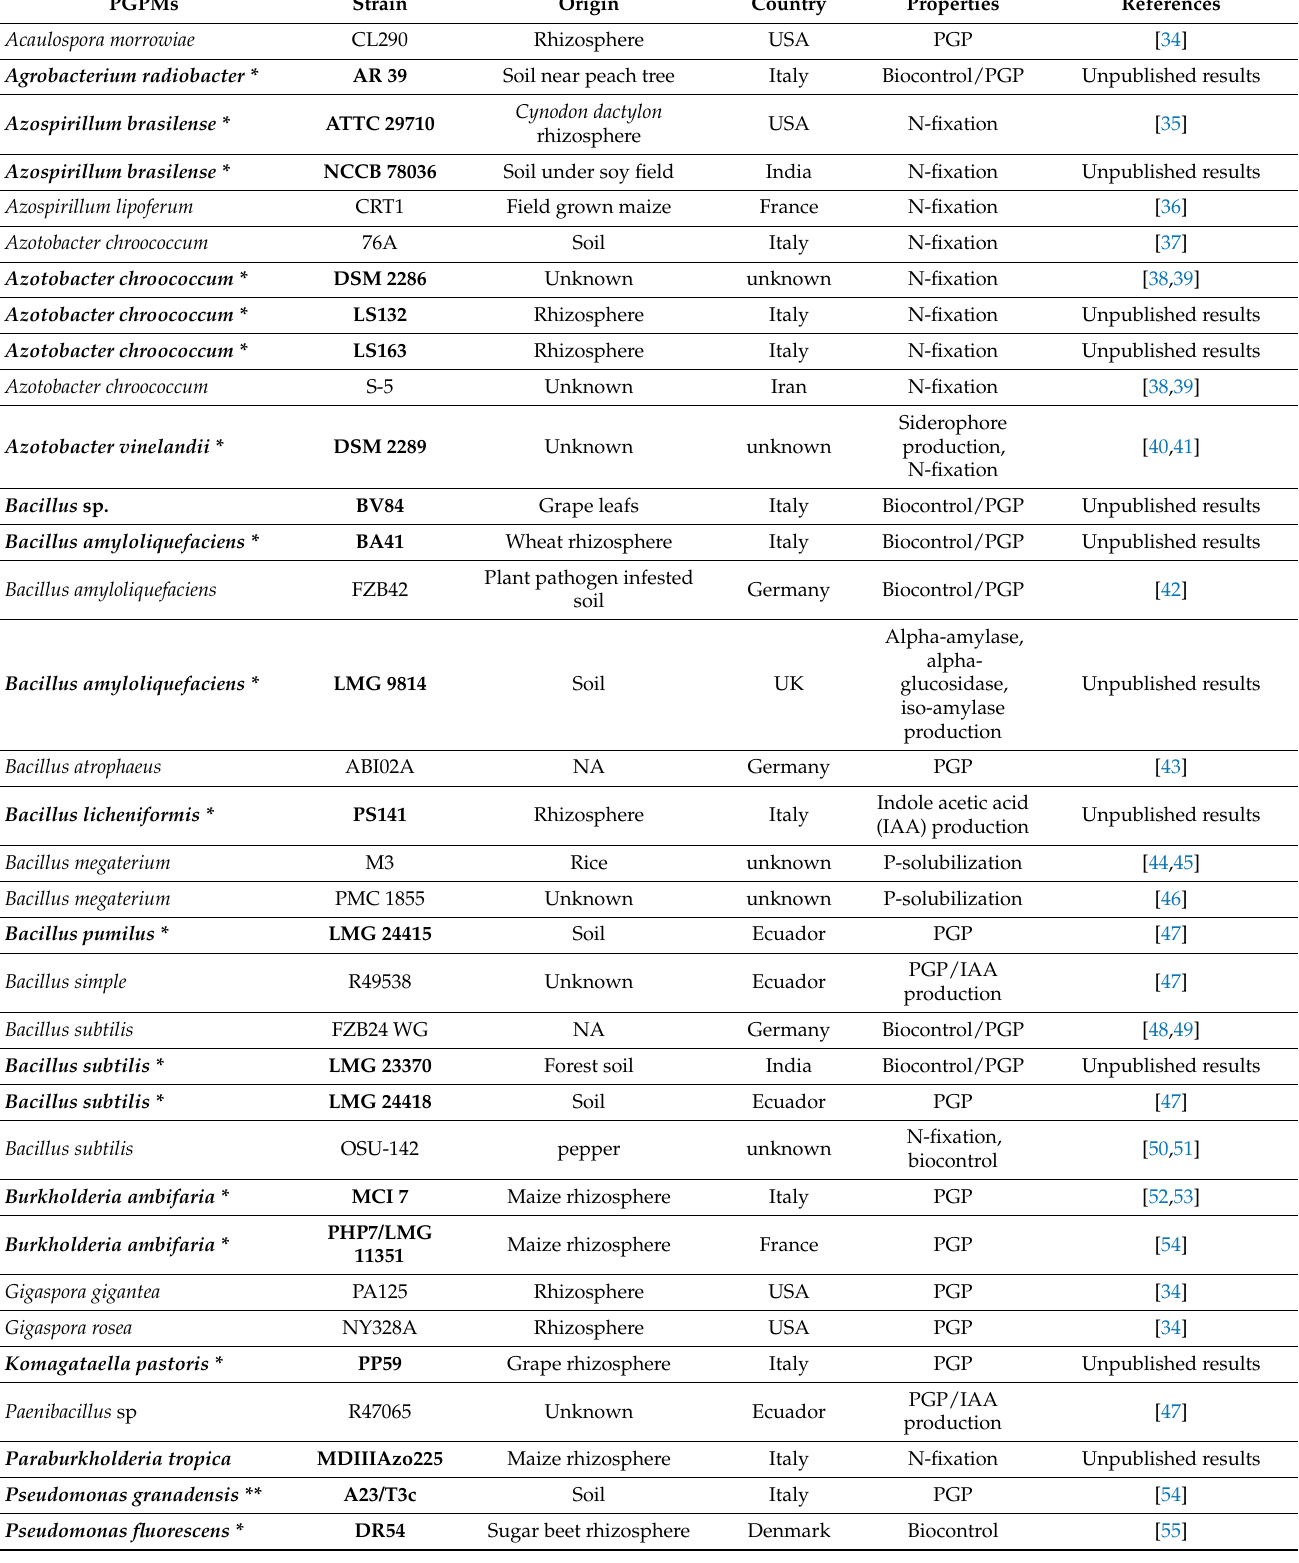
Table 1. List of the Strains Which Were Selected as Potential Plant Growth-Promoting Microorganisms (PGPMs) in this Study, Their Isolation Source, and Properties. The Species Names Were Verified According to the Latest Classification in the NCBI Taxonomy